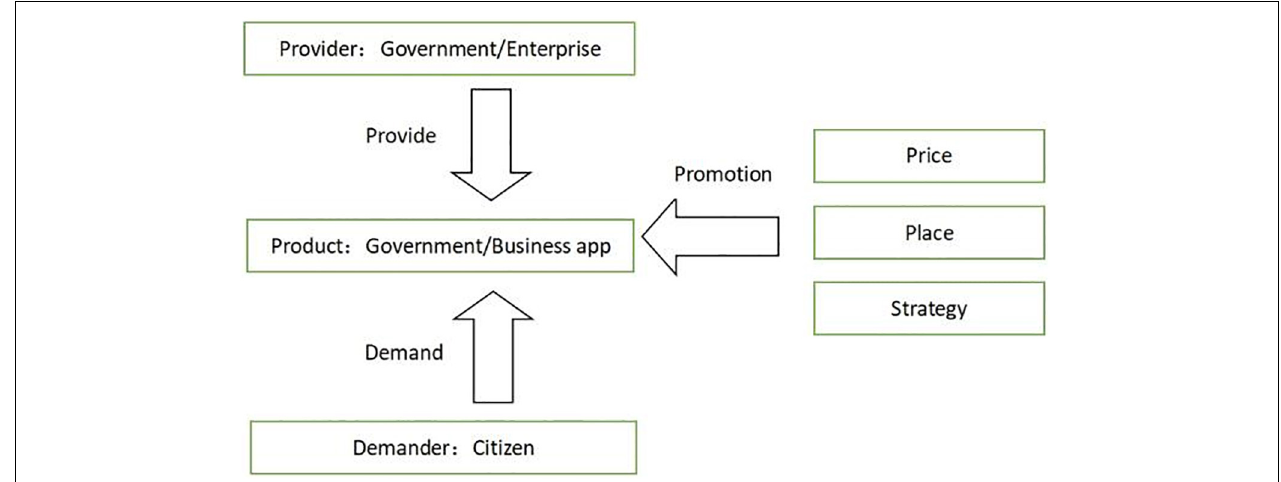
FIGURE 1 | Basic model of apps’ user activity from the perspective of supply and demand